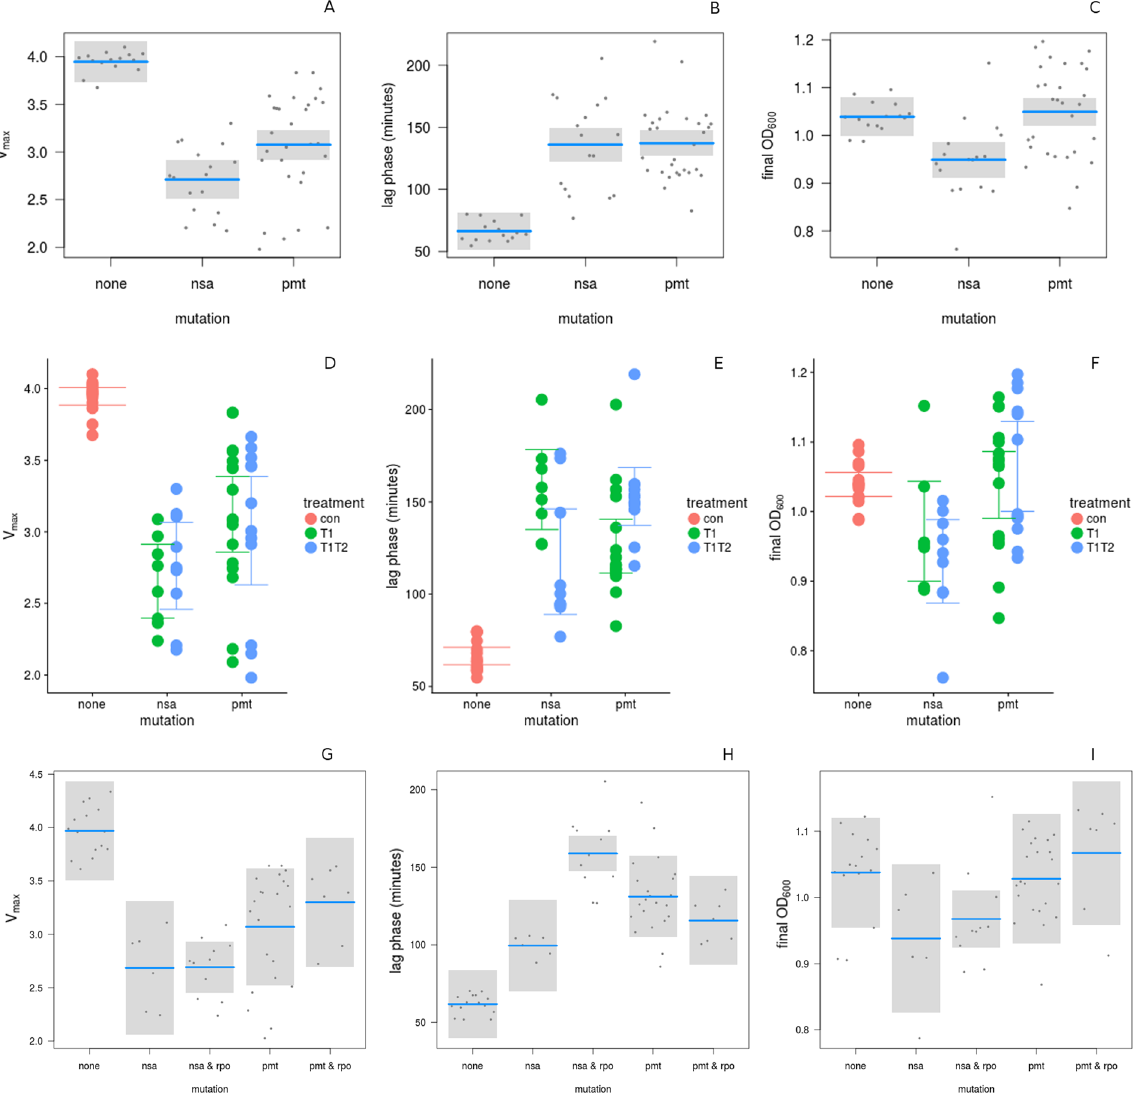
Figure 3 . Fitness costs over mutation/operon ( A – C ), in relation to the selective environment ( D – F ) and in the presence or absences of a second mutation ( G – I ). (blue line: mean, grey box: 95% confidence